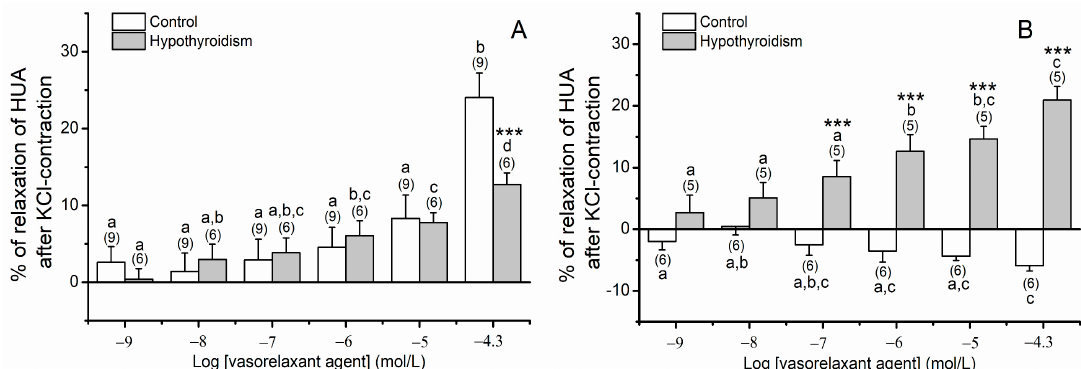
Figure 5. Percentage of relaxation of human umbilical artery (HUA) rings without (control) and with hypothyroidism incubated with ( A ) 0 µmol/L and ( B ) 50 µmol/L of octylmethoxycinnamate (OMC) and contracted by potassium chloride (KCl; 60 mmol/L). Each bar represents the mean, vertical lines the S.E.M. and the number within brackets the n . Asterisk * represents a significant difference versus hypothyroidism: *** p < 0.001, and the different letters represents significant differences between OMC concentrations ( p < 0.05); two-way ANOVA method followed by Holm–Sidak post-hoc tests.